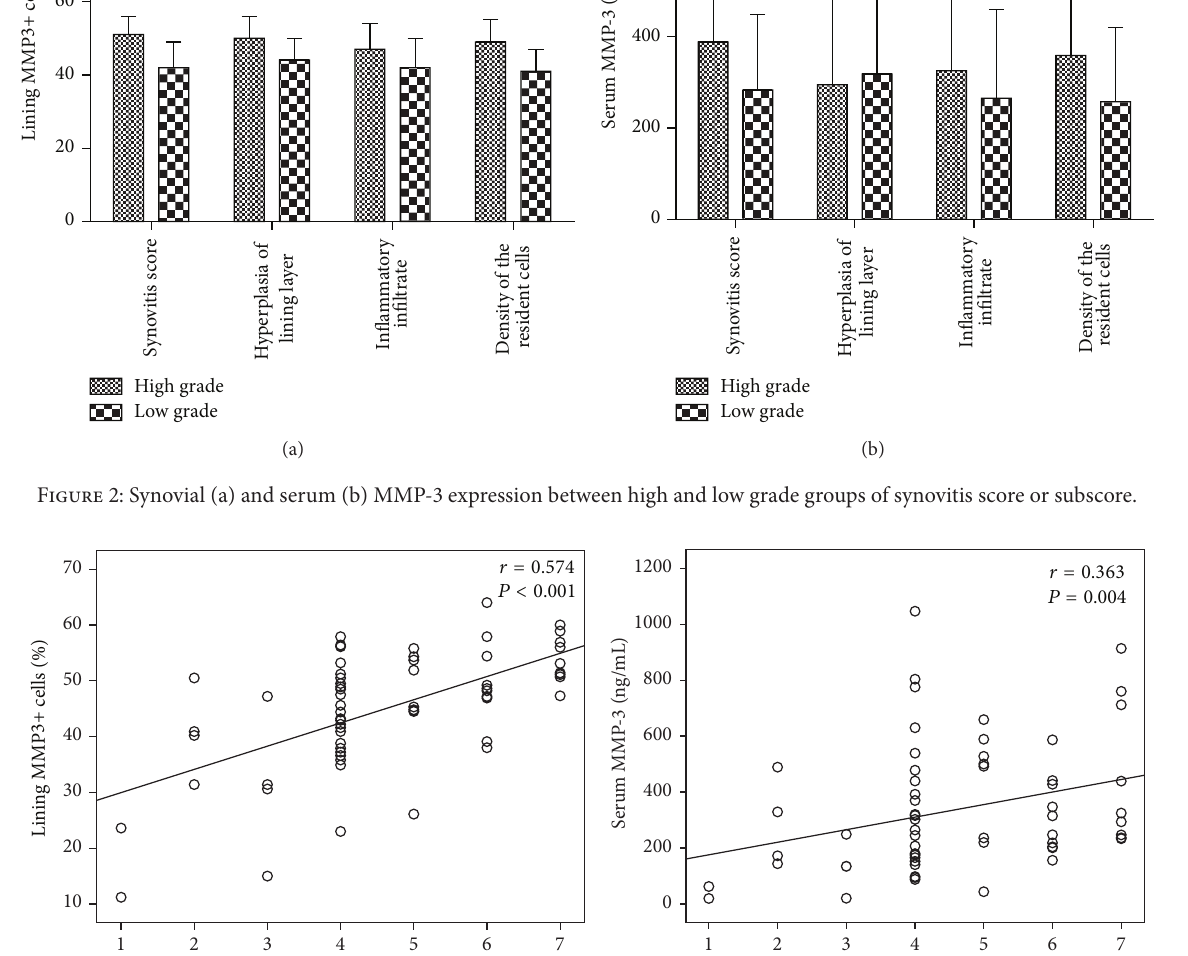
Synovitis score